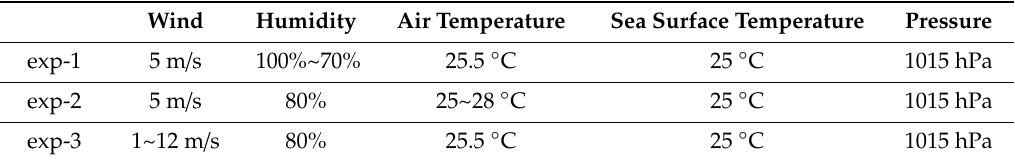
Table 1. Control experiment